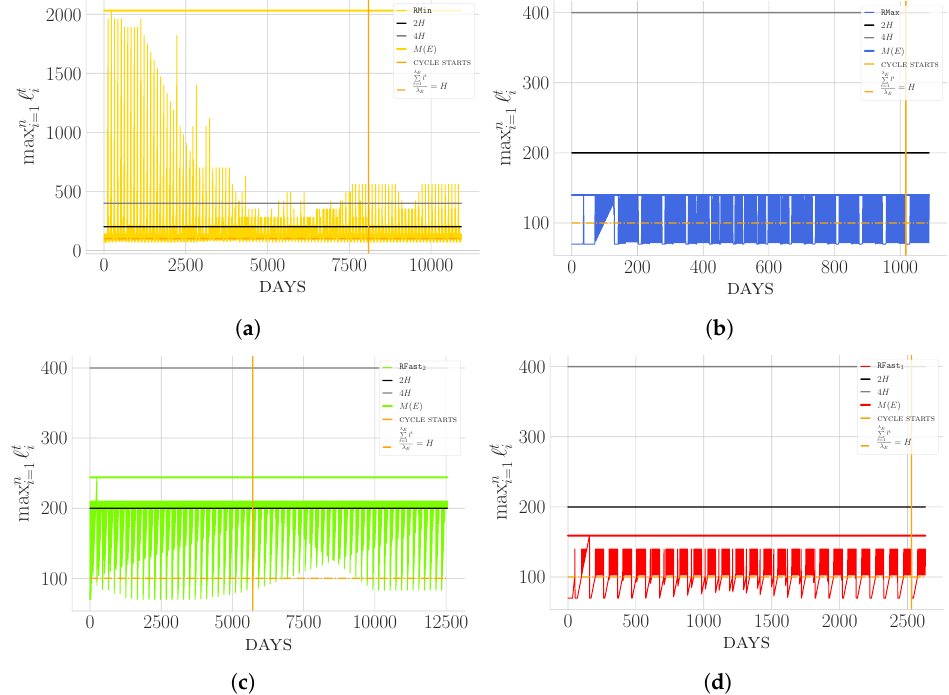
Figure 10. Snapshot of the evolution of maximum heights when strategies: RMin ( a ); RMax ( b ); RFast 2 ( c ); and RFast 1 ( d ) are applied on an instance having n = 30 and H = 100 (in details, structured as follows [ 70;2;1;1;1;1;1;1;1;1;1;1;1;1;1;1;1;1;1;1;1;1;1;1;1;1;1;1;1;1 ] ). Data are plotted as in Figure